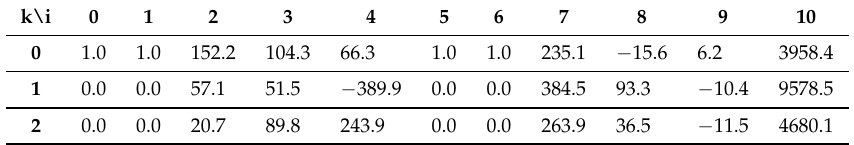
Table A8. α 6 ki